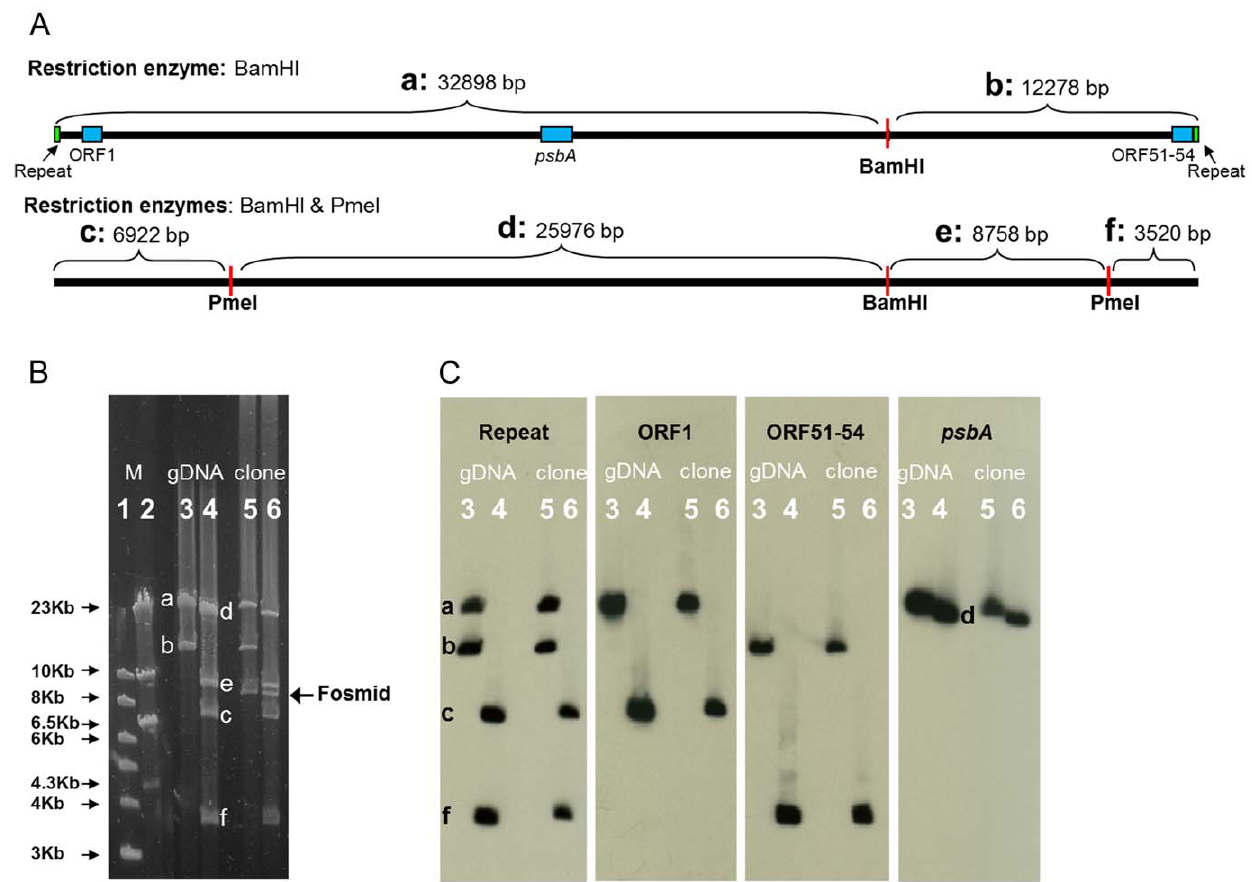
Figure 2. Digestion and Southern analyses of the P-SSP7 genome. (A) Schematic genome map showing the positions of the restriction enzyme cleavage sites (red) and the expected fragment sizes after digestion with BamHI alone (top) and both BamHI and PmeI (bottom) based on the revised genome arrangement shown in Fig. 1C. (B) Restriction digestion of the P-SSP7 genome extracted from phage particles (lanes 3 and 4) and the genome cloned into a fosmid (lanes 5 and 6), with BamHI alone (lanes 3 and 5) or with BamHI and PmeI (lanes 4 and 6), separated by pulse field gel electrophoresis. Note that the only difference for digestion of the cloned genome is the presence of an additional fragment corresponding to the size of the fosmid vector. Fragments corresponding to the expected sizes shown in (A) are marked with the appropriate letter designations (a to f). Fragment size markers (M): 1 kb DNA ladder (lane 1) and Lambda DNA cut with HindIII (lane 2), are shown. (C) Southern analyses of the restriction digested DNA in (B) using 4 probes (denoted above the lanes) show that the repeat region appears twice on the genome on the same fragments as the first and last ORFs. The positions of the gene probes on the genome are shown as light blue boxes and the repeat region probe as green boxes in the top panel of (A). Lane numbering and fragment designations are the same as in (B).